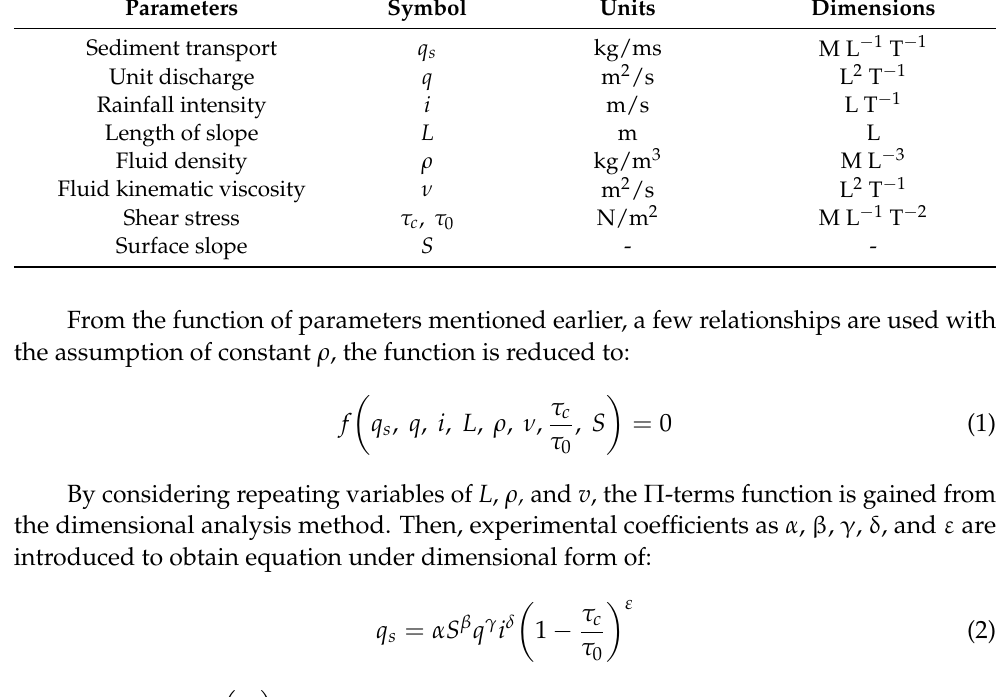
Table 2. List of parameters used in an equation by [25].